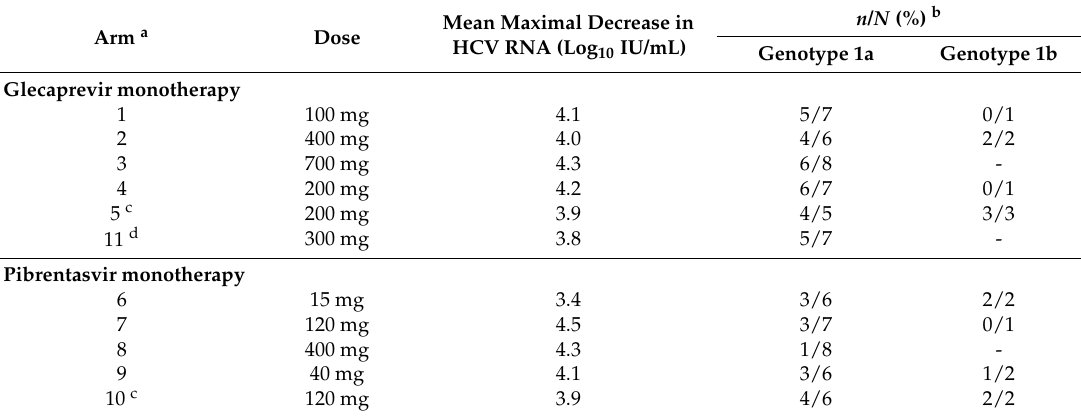
Table 1. Number of patients evaluated in sequence and resistance analyses. n / N (%) b Mean Maximal Decrease in Arm a Dose HCV RNA (Log 10 IU/mL) Genotype 1a Genotype